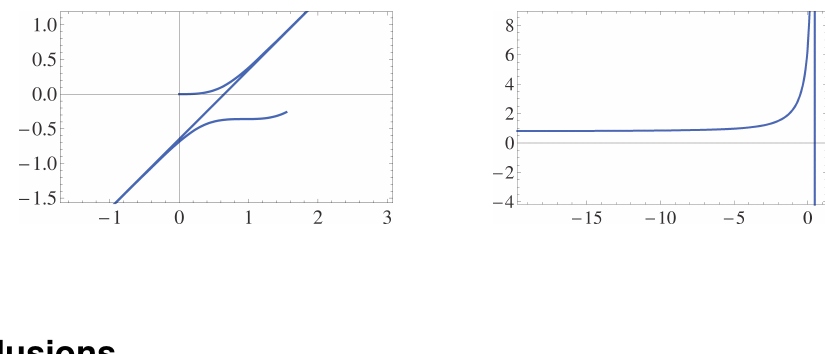
Fig. 2. The left hand side figure is obtained by formulas (38) , and that one on the right via formulas (43) . In both cases a D 2 , c D 1 and (cid:27) D 1